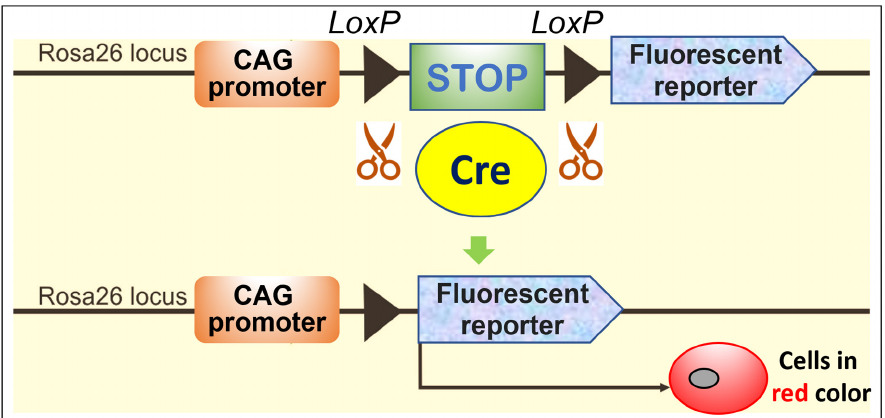
Figure 1. The mechanism of cell lineage tracing. The Cre excises the STOP sequence, and it activates the tomato reporter in the specific cell line when the mouse has both the Cre and loxP expression. As a result, this specific cell lineage is labeled in red